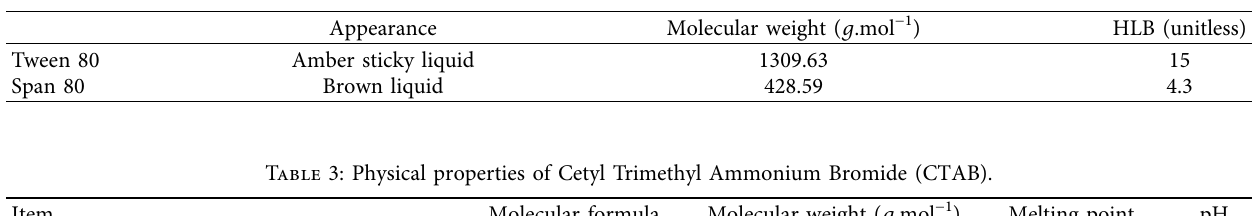
Table 2: Physical and chemical properties of span 80 and tween 80.